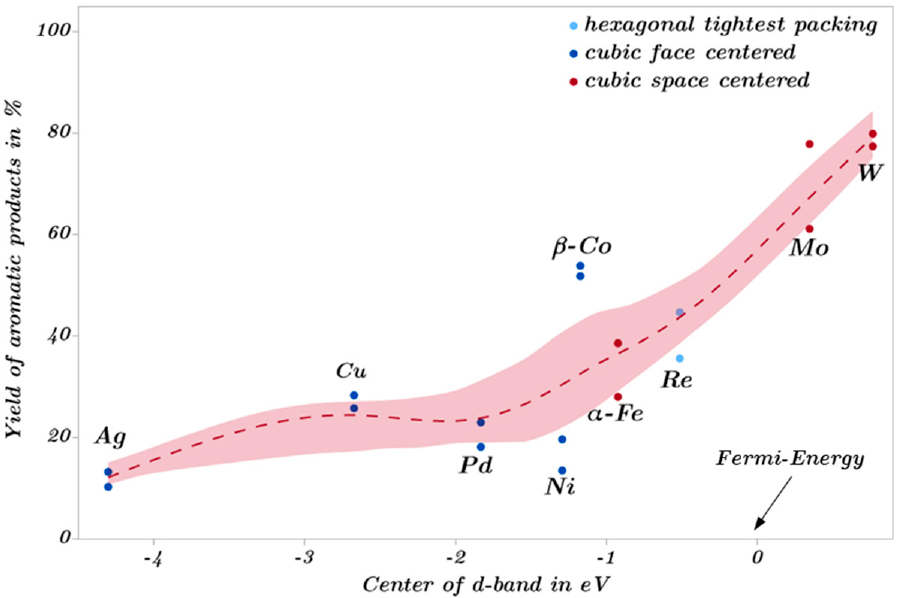
Figure 20. Dependence of the yield of aromatic products at 400 °C on the center of the d-band and the lattice type of the metal used.